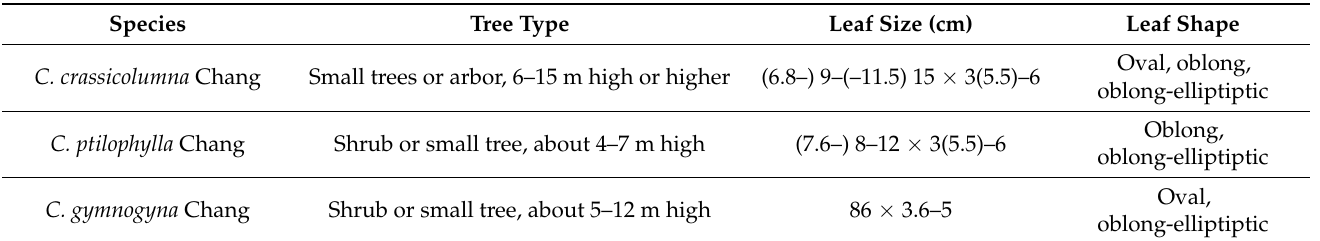
Table 2. Main morphological characteristics of trees and leaves of three Camellia